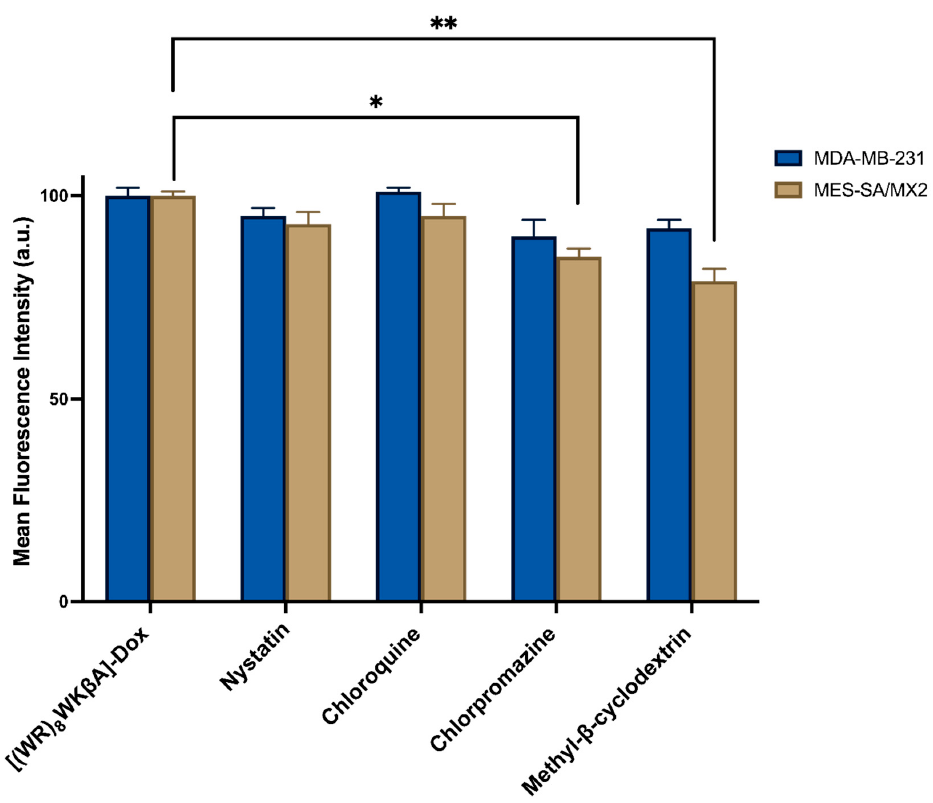
Figure 5. [(WR) 8 WK β A]-Dox conjugate cellular uptake in MDA-MB-231 and MES-SA/MX2 cells in the presence of different inhibitors of clathrin- and caveolae-dependent endocytosis, as studied by flow cytometry. Results are mean ± SD ( n = 3) (* p < 0.05, ** p < 0.01, treatment vs. Ctrl ([(WR) 8 WK β A]-Dox conjugate alone).